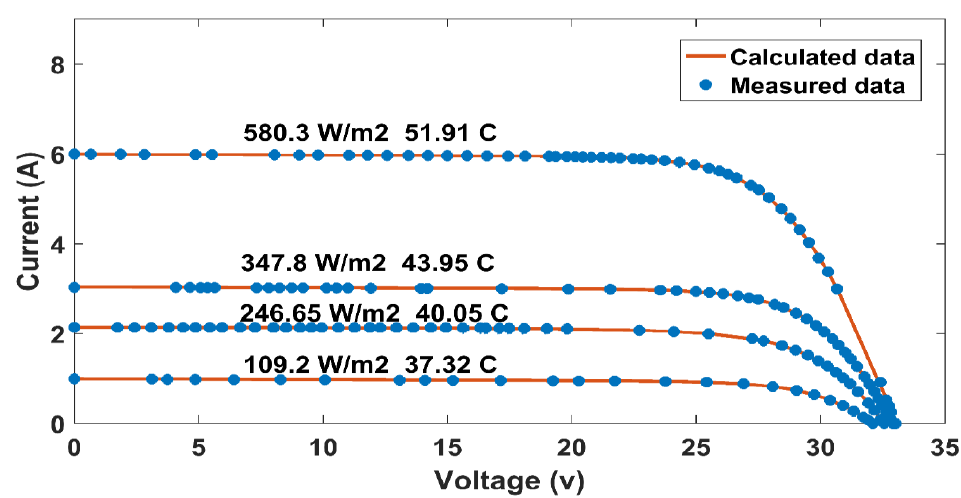
Figure 10. Measured current vs. calculated for three-diode model by CEHO.